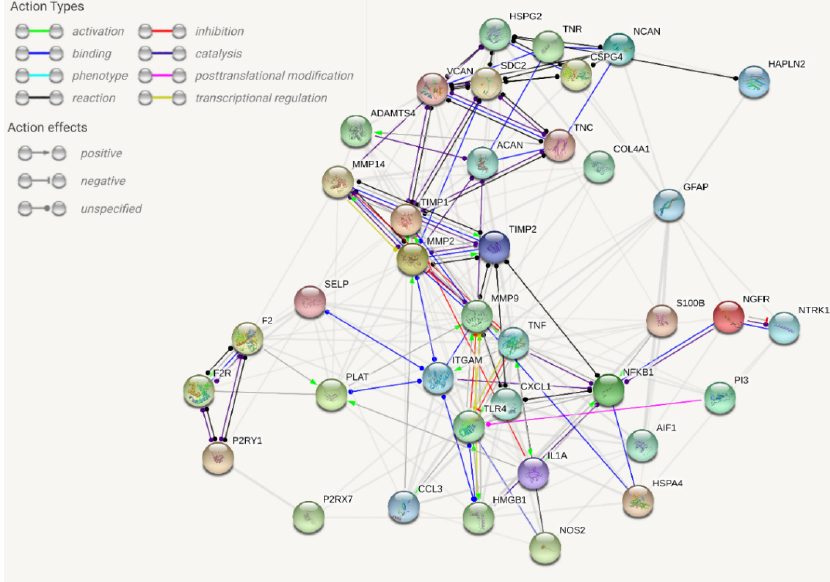
Figure 1. Extracellular/intracellular network analysis within the damaged tissue (string-db.org platform)